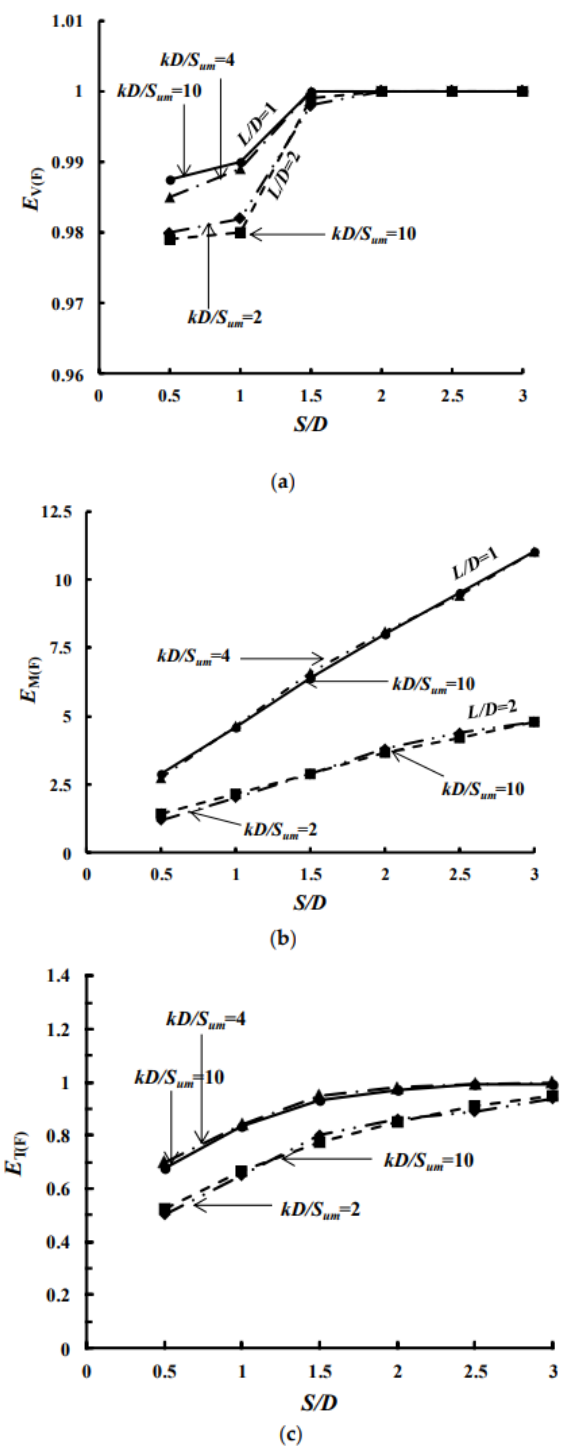
Figure 15. Comparison of group efficiency factors at various kD / S um ratios: ( a ) vertical efficiency, ( b ) moment efficiency and ( c ) torque efficiency.